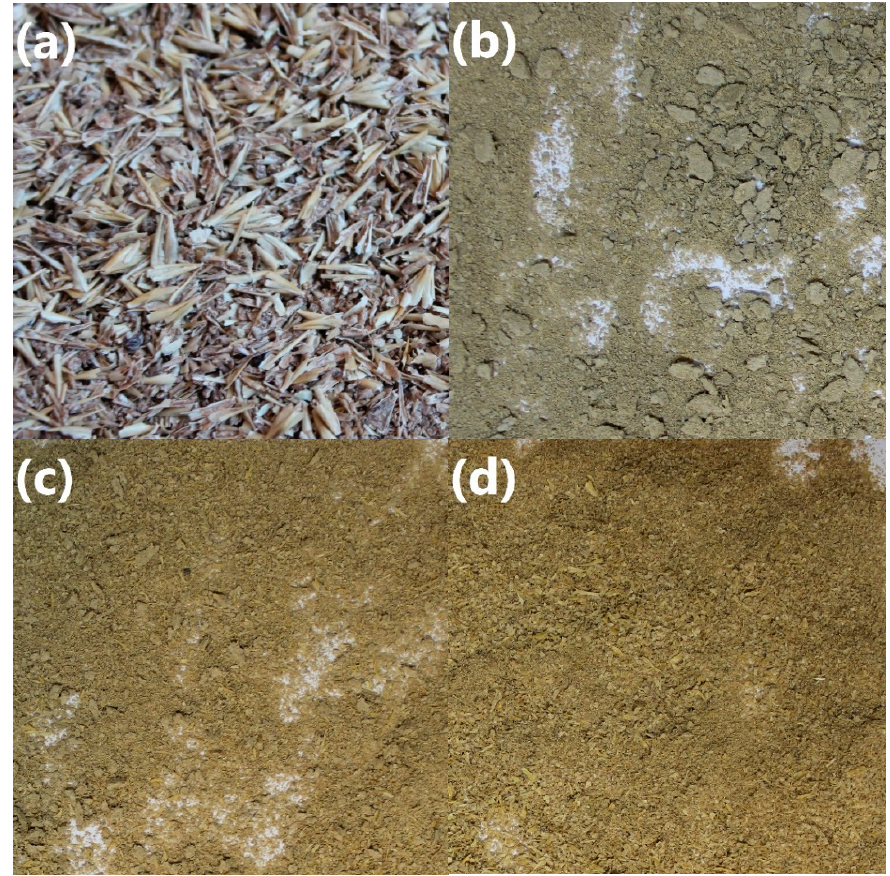
Figure 2. The appearance of ( a ) neat BSG, and extruded at ( b ) 60 °C, ( c ) 120 °C, and ( d ) 180 °C.